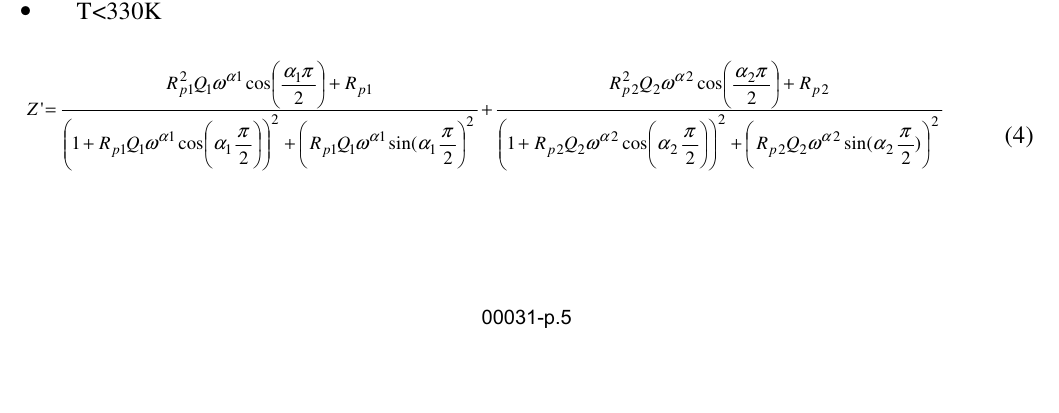
Fig.5. 13 C CP/MAS spectrum of C 2 H 10 N 2 Cd(SCN) 2 (Cl) 2 having direct dipolar coupling to 14 N nuclei: (a) experimental spectrum; (b): calculated